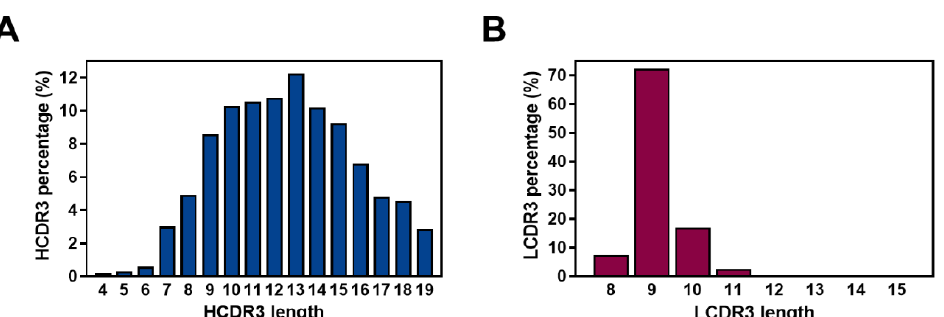
Figure 5. Length diversity of heavy and light chain complementarity-determining region 3 (CDR3) in the constructed library. Frequencies of heavy chain CDR3 (HCDR3, blue) ( A ) and light chain CDR3 (LCDR3, red) ( B ) with diverse lengths are expressed as percentage bar graphs. The HCDR3 and LCDR3 length ranges were 4–19 and 8–15 amino acids, respectively.